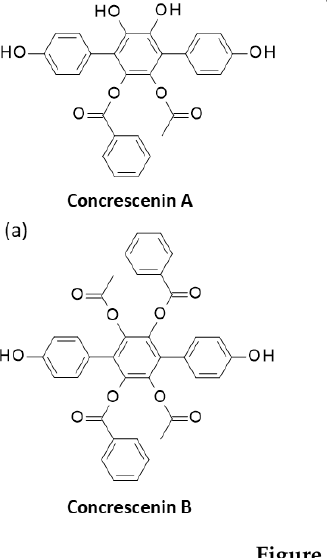
Figure 6. ( a ) Structure of concrescenins A and B. ( b ) Ribbon model of concrescenin B bound to the V98 site of USP4, with a close-up view of the compound in the binding site, and the solvent acces- sible surface (SAS) colored (color code indicated). ( c ) Binding map contact, with the indicated color code.